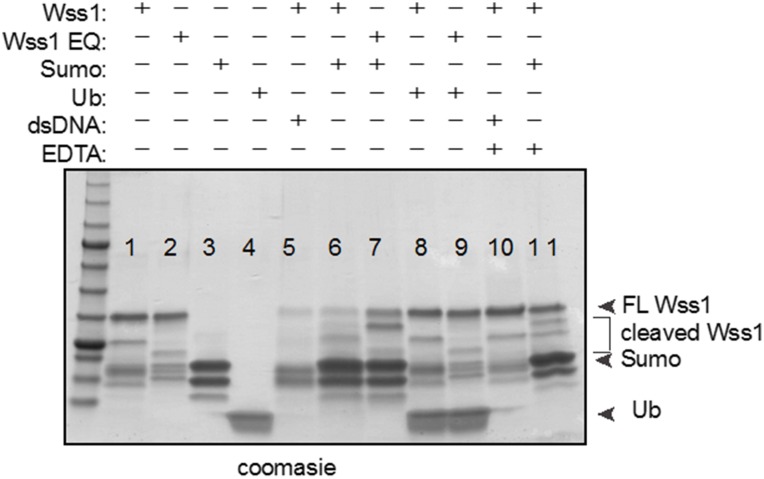
DOI:
http://dx.doi.org/10.7554/eLife.21491.015